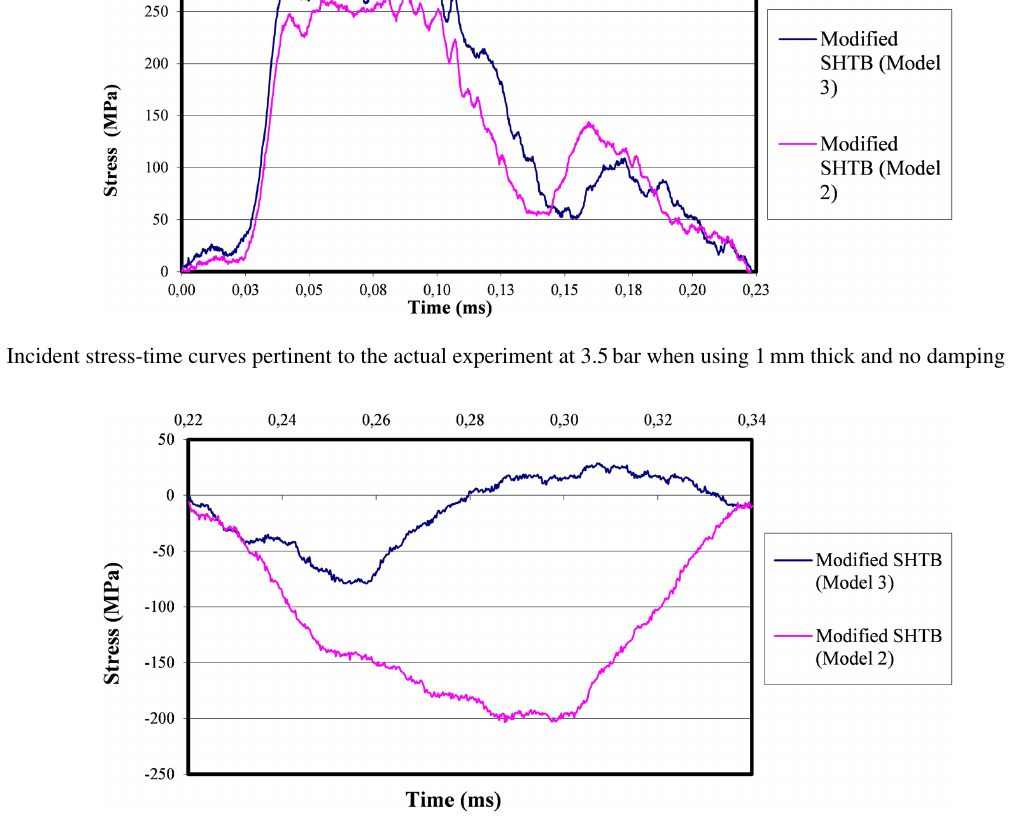
Figure 27. Reflected stress-time curves pertinent to the actual experiment at 3.5bar when using 1mm thick and no damping rings.